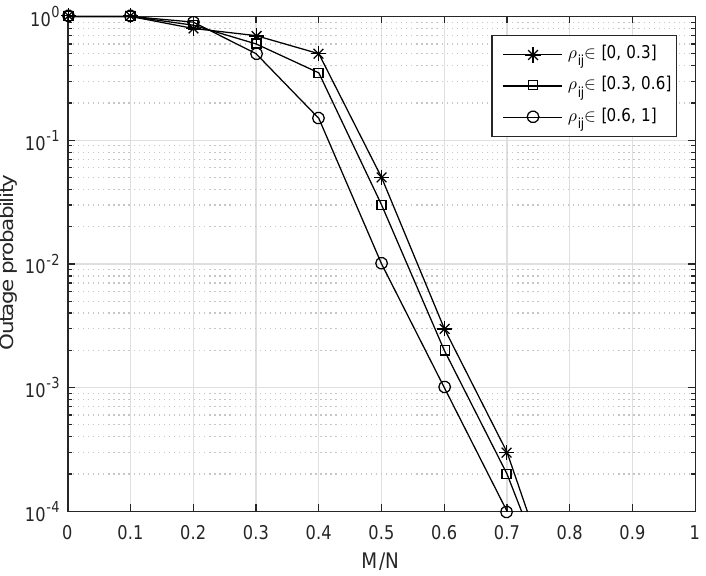
Figure 2. Outage probability with different sparsity levels.